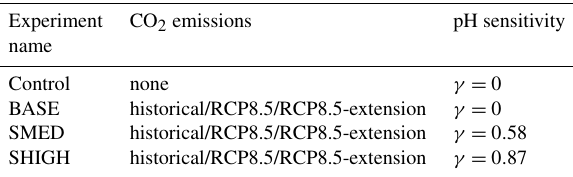
Table 1. Model experiments conducted for this study. All experi- ments have been run over the time period 1850–2200. The exper- iments BASE, SMED and SHIGH use prescribed CO 2 emissions (and other forcings) following the CMIP5 protocols for the histori- cal simulation (1850–2005), the RCP8.5 scenario (2006–2100) and the RCP8.5 scenario extension